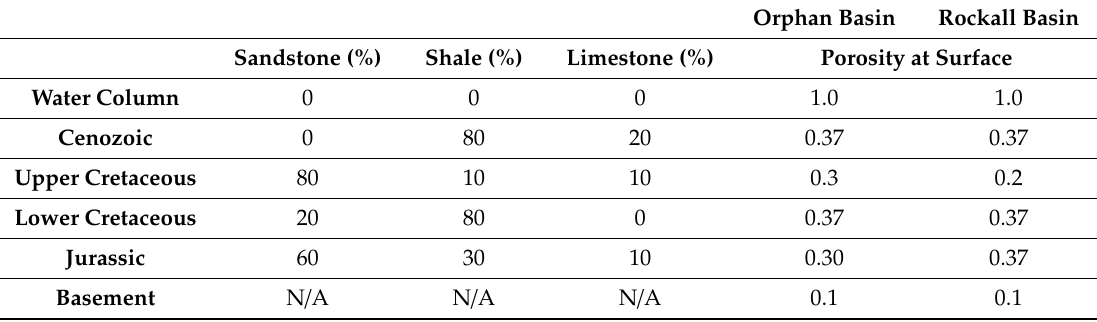
Table 3. Lithological compositions (as per [43]) and porosity values (for each basin) for each stratigraphic unit used in the decompaction calculations within MOVE TM